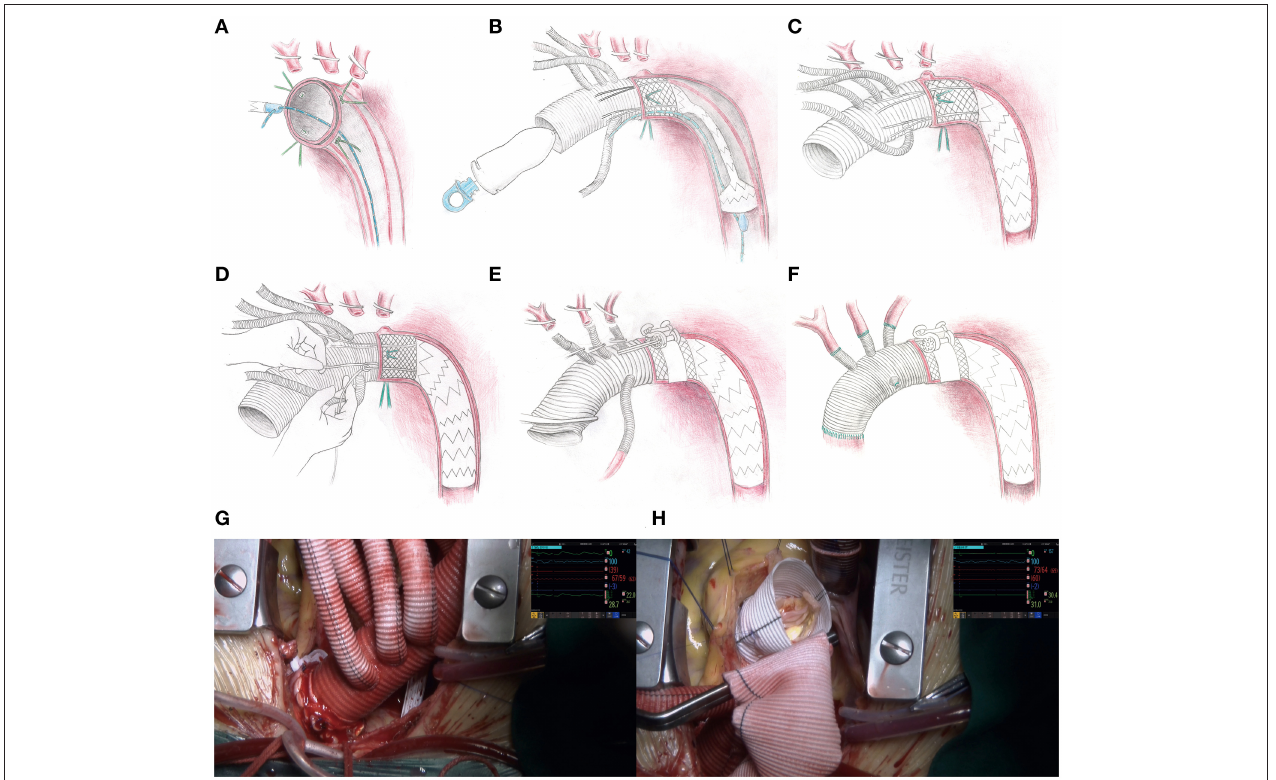
FIGURE 2 | Operative procedure for the SIS graft prosthesis and video screenshots of the operation. (A) The aortic arch is dissected transversely, four sutures are applied evenly around the aortic wall, and a retrogradely inserted guidewire is threaded through an eyelet on the distal end of the delivery system. (B) The sutureless region and stented-graft region are deployed into the descending aorta over the guidewire and released by drawing out the pull ring on the proximal end of the delivery system. (C) The guidewire and delivery system are removed from the femoral access and the proximal orifice of the 4-branched vascular graft trunk, respectively. (D) The restraint sutures are securely tightened and tied in situ , and then tied with the corresponding silk sutures already threaded on the aortic wall. (E) The perfusion to the lower part of the body is restarted via the femoral cannula. On the area corresponding to the sutureless elastic support annulus, a sutureless belt is looped around the aortic adventitia and then fastened by truning the ratchet with the wrench. (F) The supra-aortic vessels and ascending aorta are anastomosed. (G) The appearance of the distal anastomosis site after fastening the sutureless belt. (H) The operative field is clear without bleeding from the distal anastomosis site when performing the David